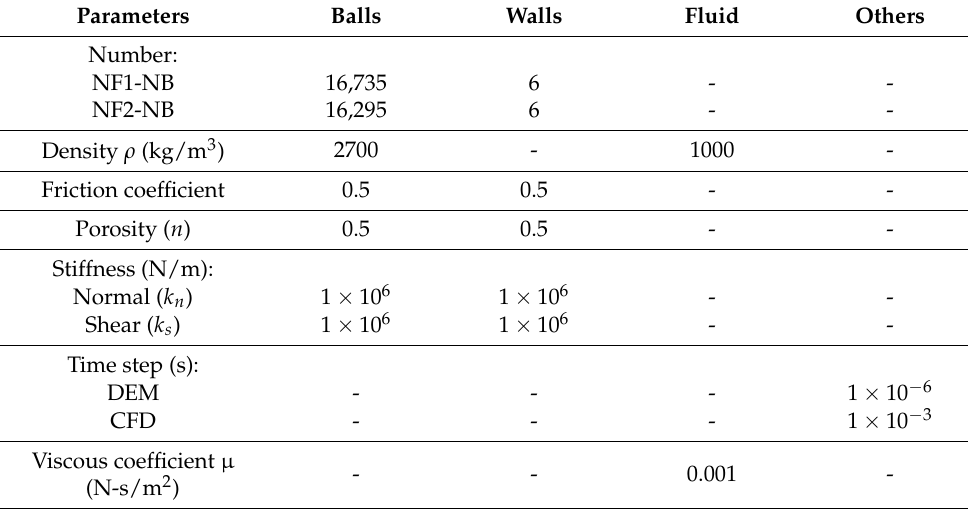
Table 1. Summary of parameters for the numerical